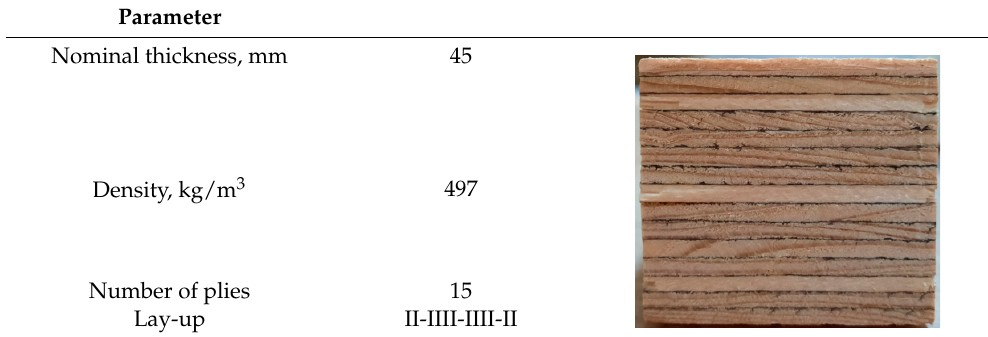
Table 1. LVL panel technical specifications.